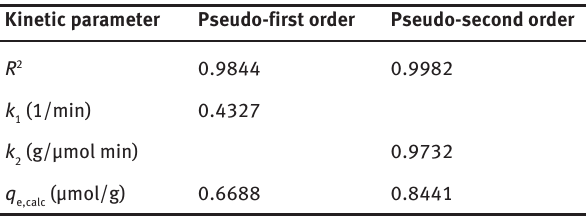
Table 1: Kinetic parameters for adsorption of Cr(VI) ions onto the µSiO @Cr(VI)-IIL at temperature 25°C. 2